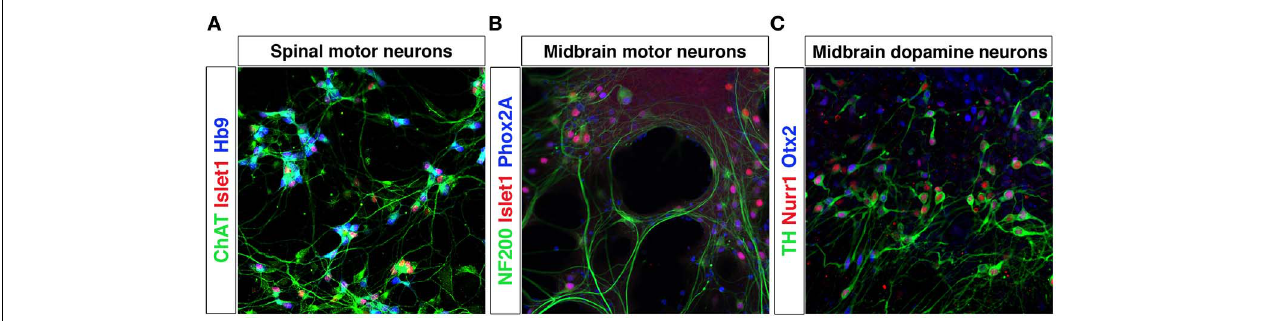
FIGURE 4 | Differentiation of mESCs into spinal motor neurons and midbrain neurons. Spinal motor neurons (MNs) were generated from Hb9-GFP mESCs using RA and SAG (A) . MNs express Islet-1, have a healthy appearance and extend processes. Exposure of